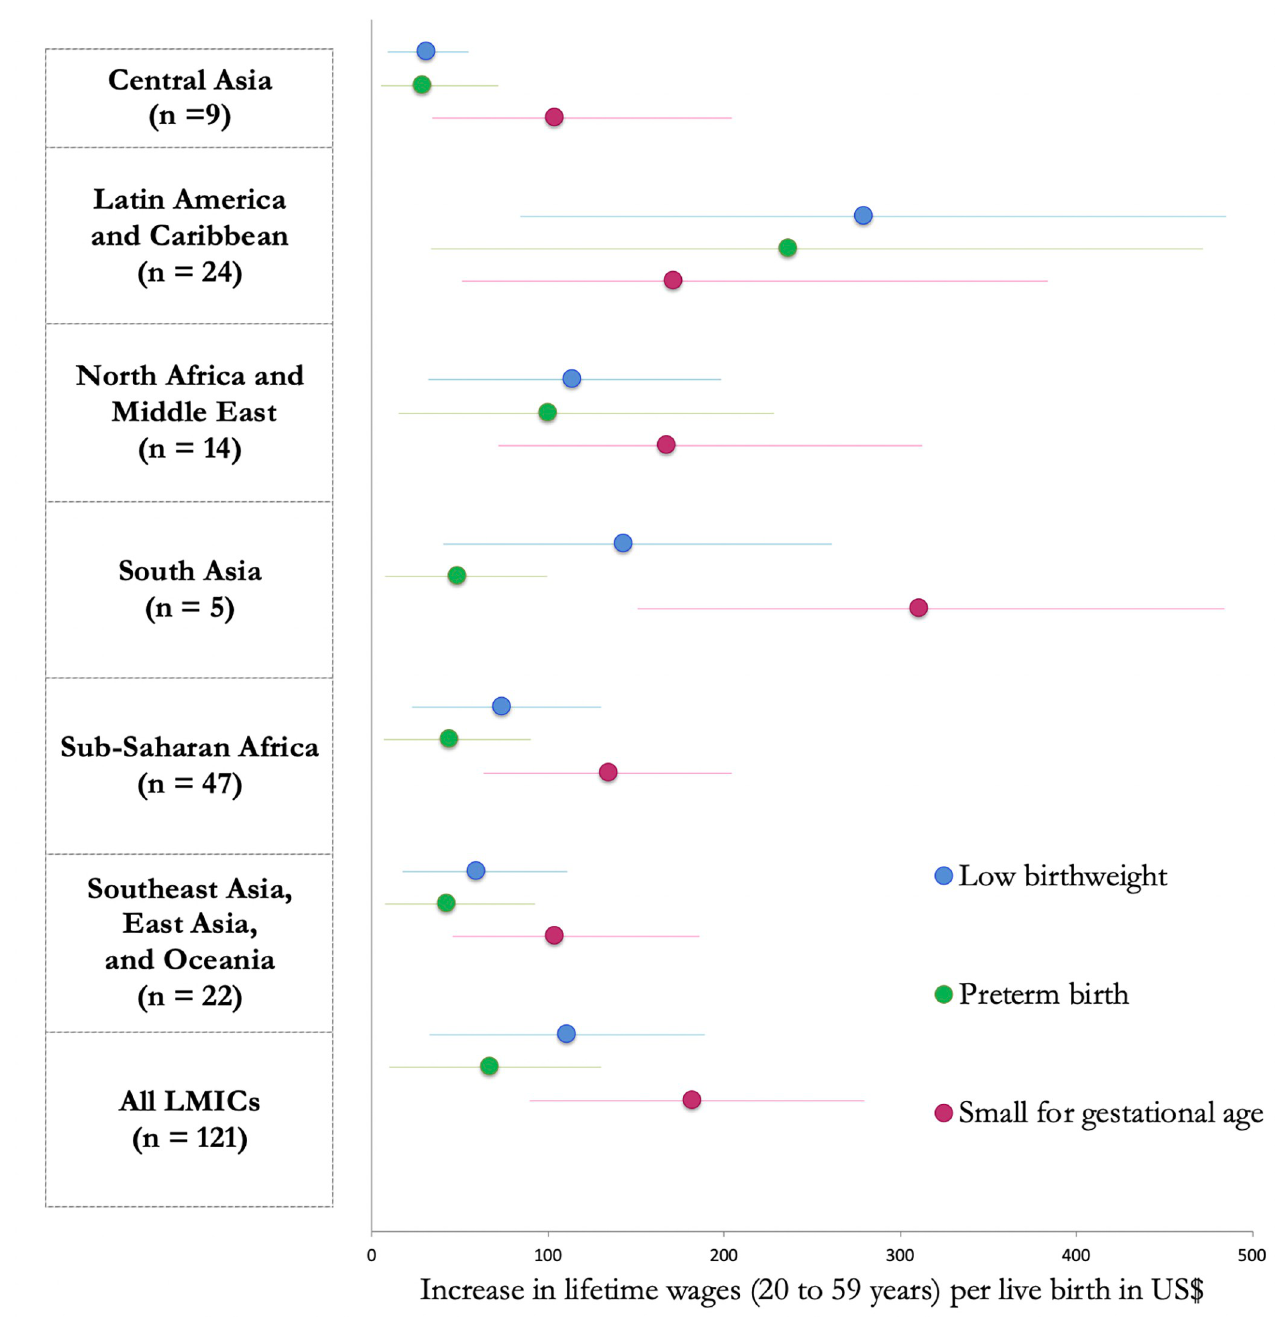
Fig 2. Population average gains in lifetime income per child born in US$, by